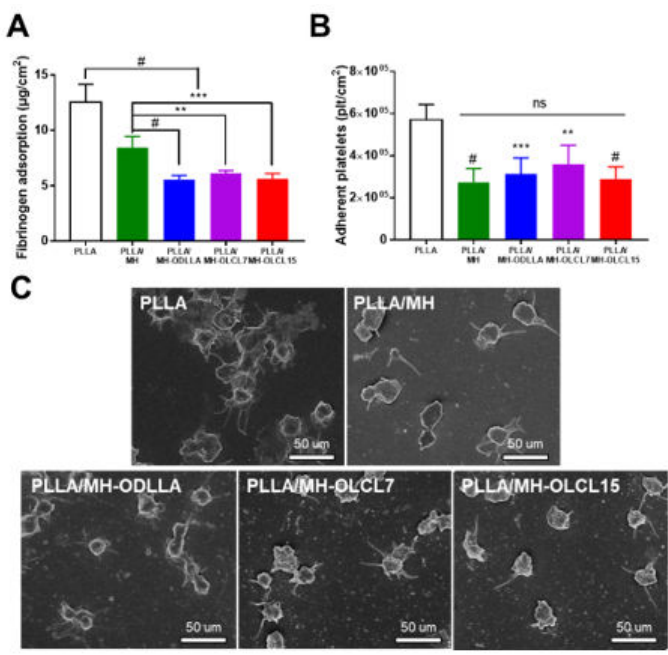
Figure 6. ( A ) Fibrinogen adsorption, ( B ) the number of activated platelets, and ( C ) SEM images of adherent platelets on the surface of PLLA/MH composites. Scale bar: 50 µ m (* p < 0.05, ** p < 0.01, *** p < 0.001, and # p < 0.0001).